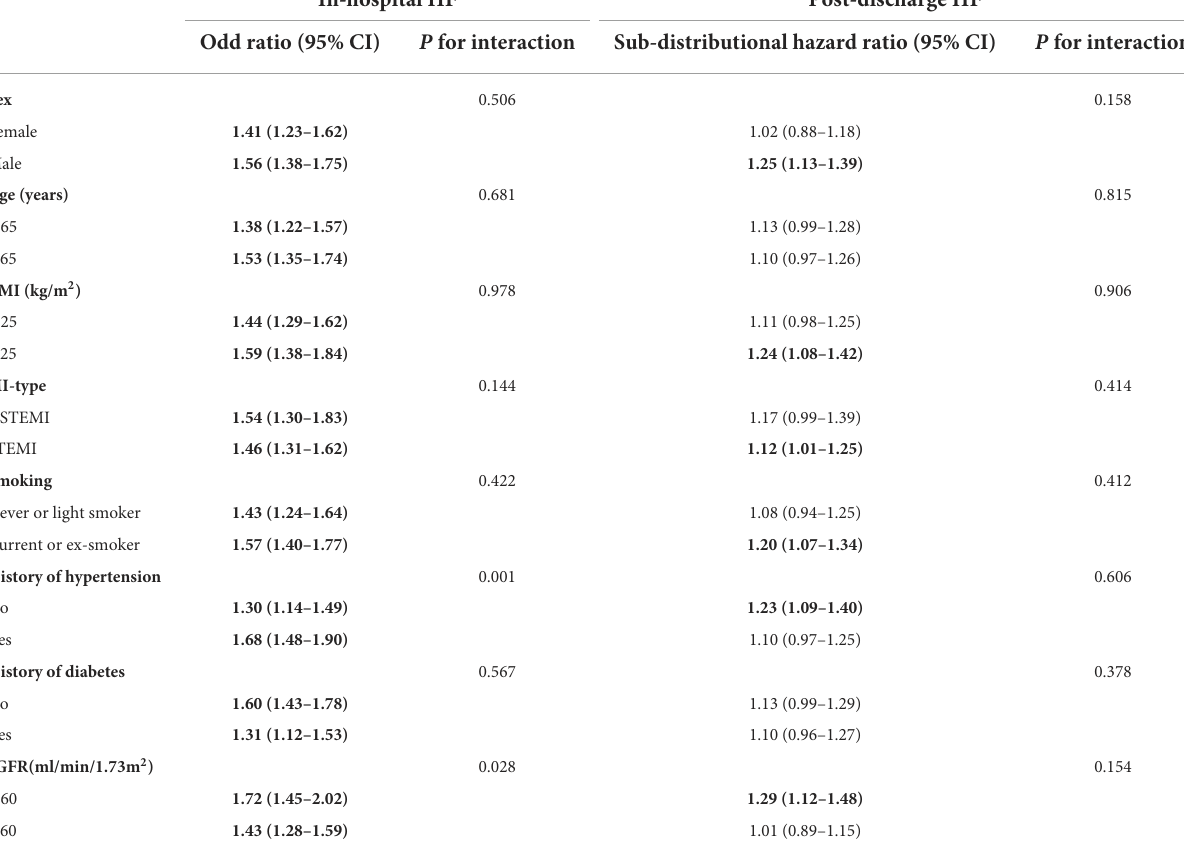
TABLE 4 Stratified analysis of in-hospital HF and post-discharge HF for serum